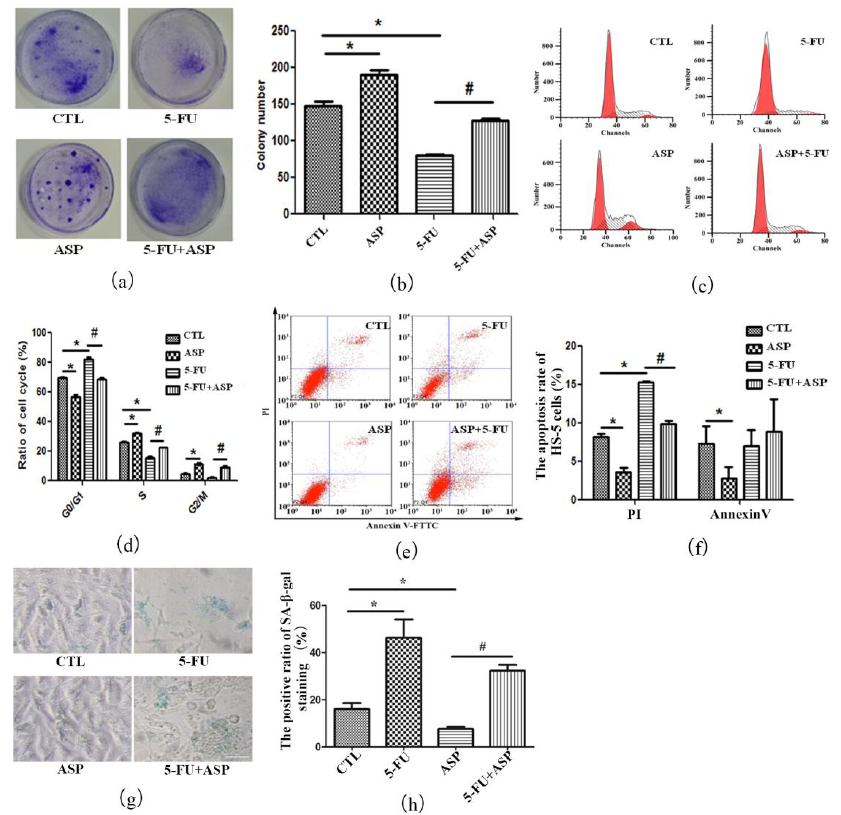
Figure 2. Angelica sinensis polysaccharide (ASP) rescues HS-5 cell growth inhibition after 5-FU treatment via anti-apoptosis and anti-senescence effects. ( a ) HS-5 cells treated with 5-FU, ASP, or a combination of both were cultured for 12 days, then stained by 0.5% crystal violet. CFU-F clusters are blue stained in dishes; ( b ) CFU-F frequency in different groups is presented as means ± SD; ( c ) Representative flow cytometry graphs of cell cycle analysis of HS-5 cells are shown; ( d ) The results of cell cycle distribution of HS-5 cells are presented as means ± SD; ( e ) Annexin V/Propidium iodide (PI) staining was employed to detect apoptotic HS-5 cells by flow cytometry. In each chart, upper left represents necrotic cells; bottom left represents vital cells; upper right represents intermediate-stage and late-stage apoptotic cells; and bottom right represents early-stage apoptotic cells; ( f ) The percentage of apoptotic HS-5 cells in different groups is presented as means ± SD. The left panel represents the ratio of intermediate-stage and late-stage apoptotic cells positively stained by PI. The right panel represents the ratio of early-stage apoptotic cells positively stained by Annexin V; ( g ) Senescence-related SA- β -gal staining was employed to detect senescent HS-5 cells. Senescent cells are blue-green stained (Scale bar = 50 µ m); ( h ) The positive ratio of SA- β -gal staining is presented as means ± SD. * p < 0.01 vs. control group, # p < 0.01 vs. 5-FU